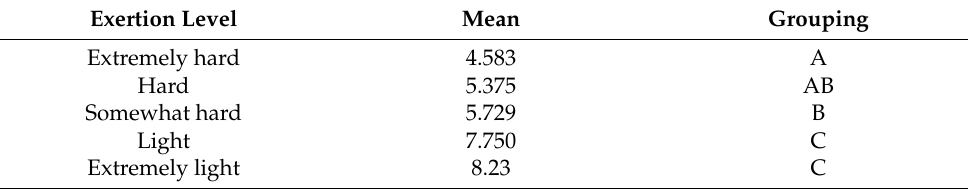
Table 9. Results of Tukey’s simultane ous tests for differences in the rate of perceived physical comfort scores at various levels of physical exertion. NS: not significant. Table 8. Summary statistics for the rate of perceived physical comfort scores at various levels of physical exertion (Tukey pairwise comparison at the 95% confidence level).